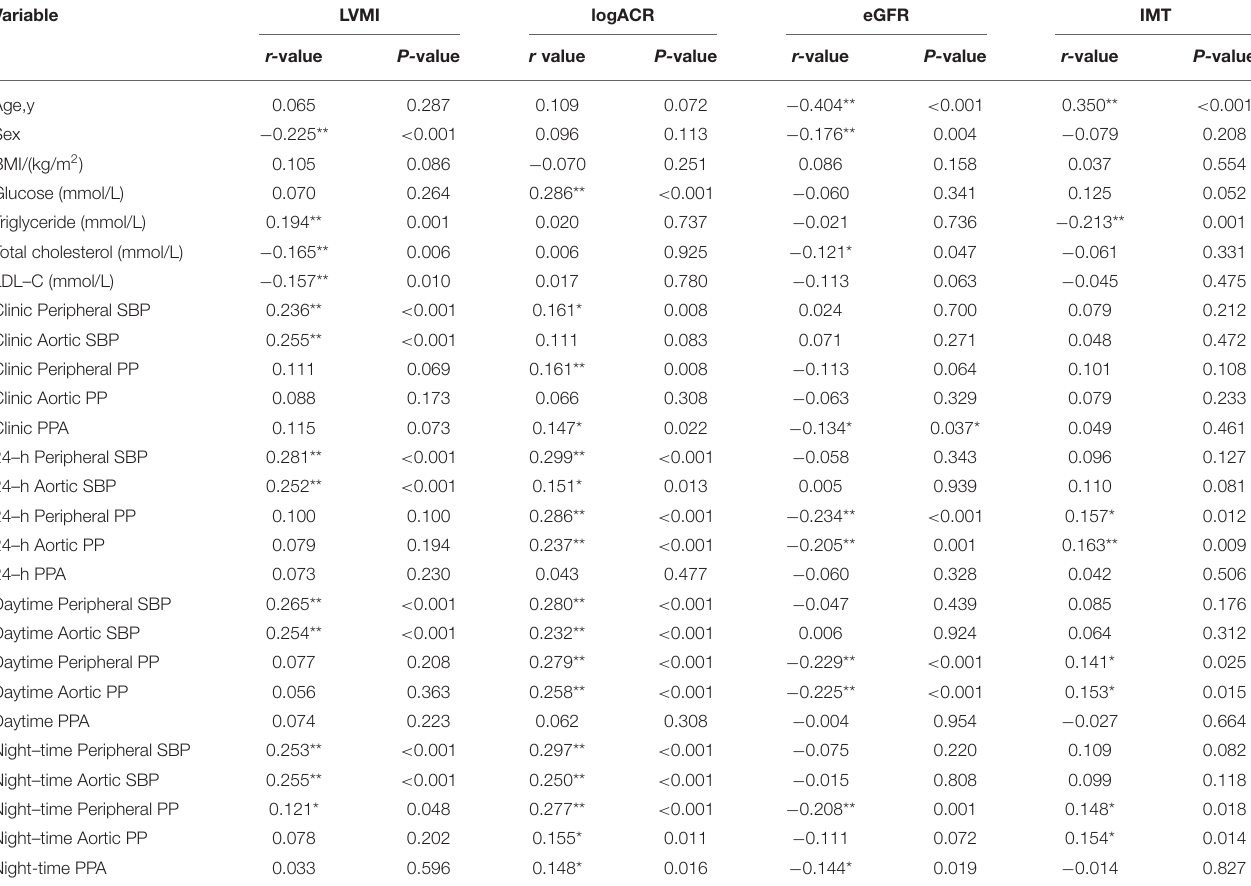
TABLE 2 | Relationship between BP and HMOD.